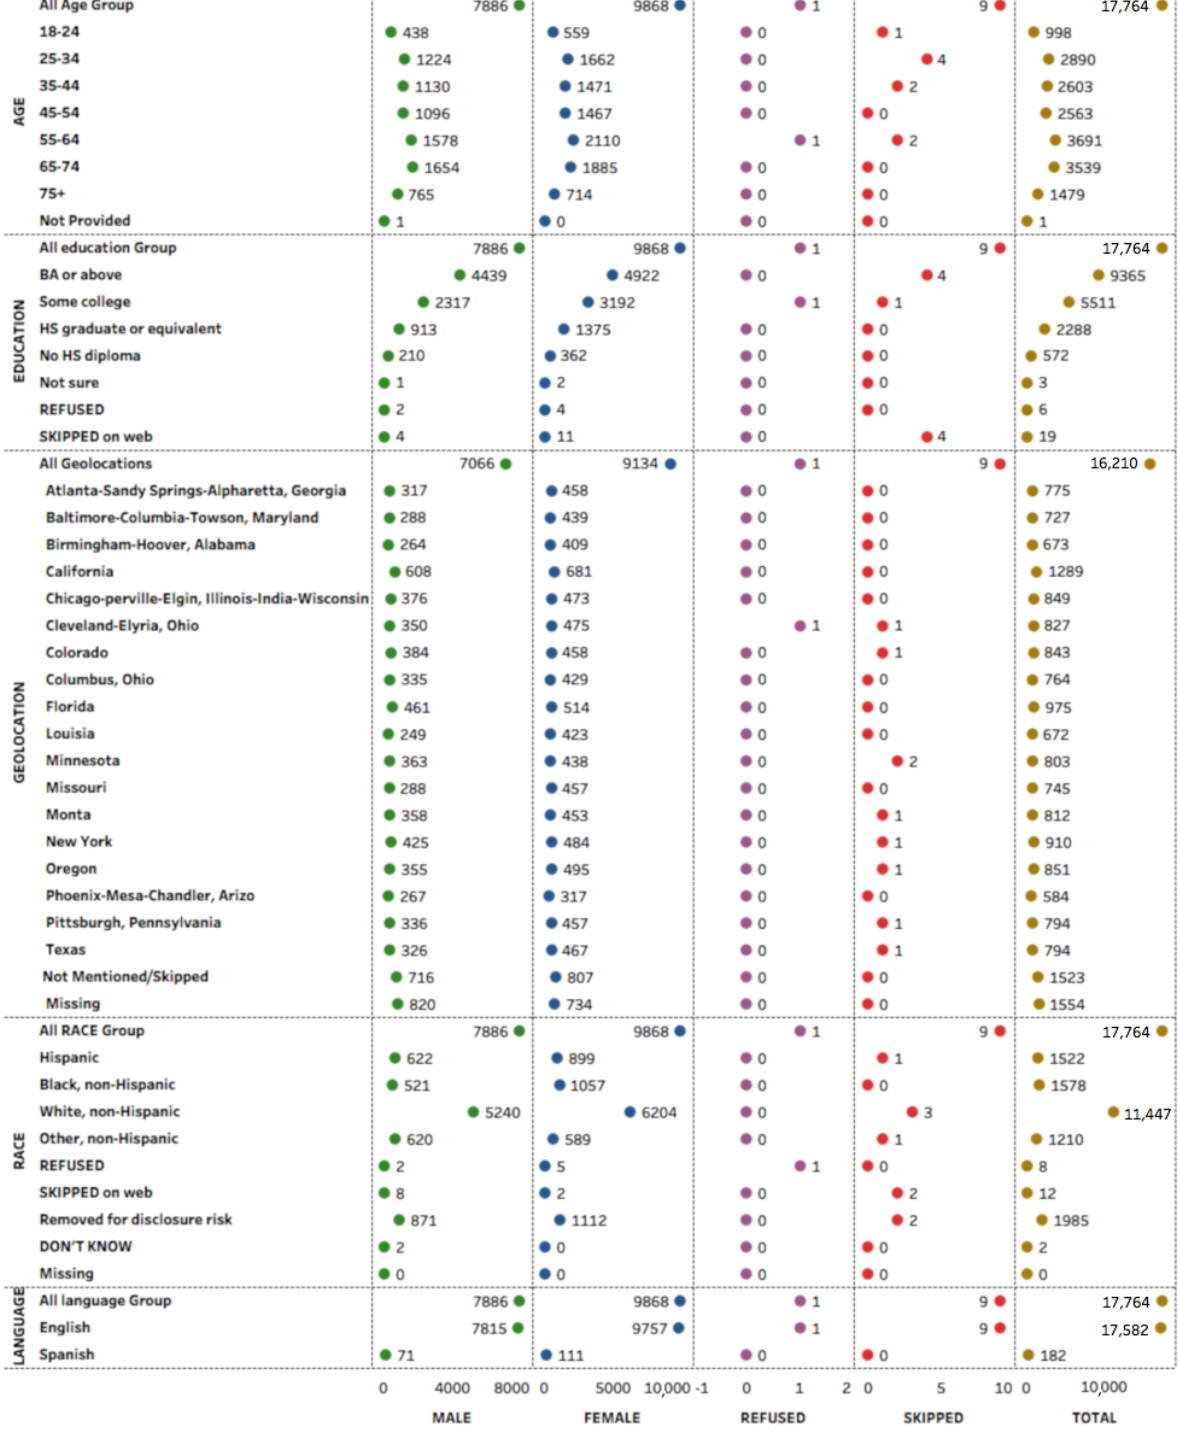
Figure 1. Sociodemographics of respondents who participated in the survey. It can be seen that there was almost a similar representation from both genders. Age groups 25-75 years were predominantly captured in the survey. Most of the respondents had received a Bachelor's degree or above and were nearly equally distributed across geographies within the United States. HS: high